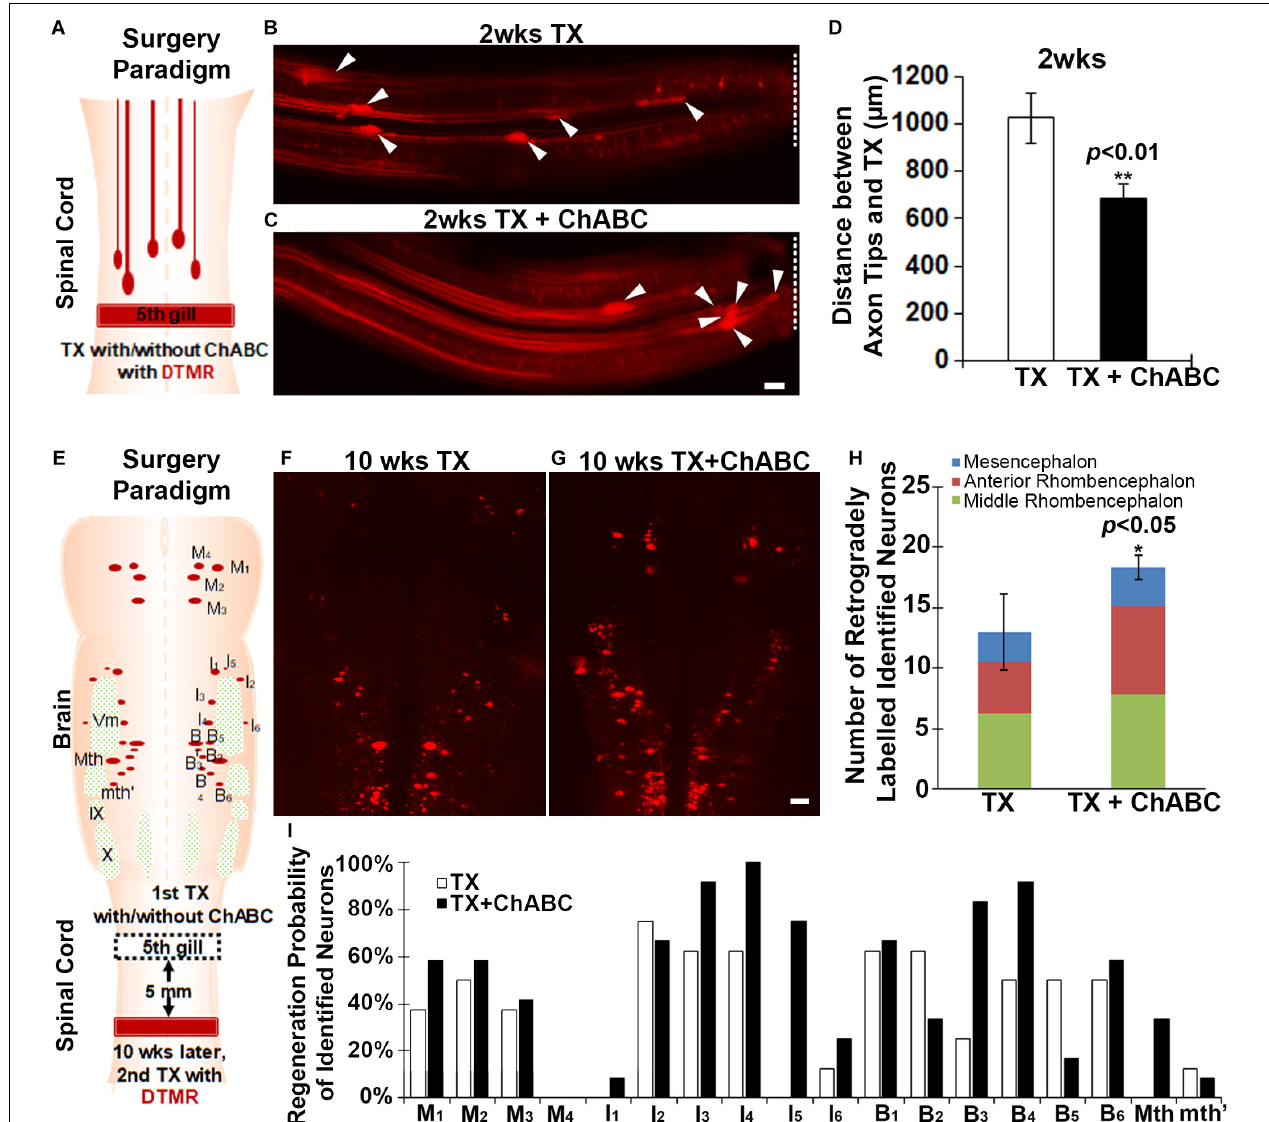
FIGURE 2 | ChABC slows initial axon retraction in vivo at 2 weeks and promotes axon regeneration in vivo at 10 weeks post-TX. (A) Experimental design for detecting the axon tips at 2 weeks post-TX. A solution of DTMR and either ChABC or control enzyme buffer was applied to a fresh spinal cord TX. (B,C) Axon tips (arrowheads) in the lamprey spinal cord back-filled with DTMR at 2 weeks post-TX (TX sites are labeled by dashed lines). (D) Mean distances of axon tips from the center of the TX site (dashed line). ** p < 0.01, n = number of axon tips. (E) Experimental design for detecting the neurons whose axons have regenerated by 10 weeks post-TX. The TX site was treated with either control enzyme buffer (F) , or ChABC (G) at the time of injury. Ten weeks later, DTMR was applied to a second TX 5 mm caudal to the first, and 1 week allowed for retrograde transport of the dye. (H) A graph showing an increased number of retrogradely labeled neurons in brains of animals treated with ChABC compared to controls. (I) The probability for each identified neuron that its axon will have regenerated at 10 weeks post-TX. * p < 0.05, n = 5 lampreys per group. Error bars: SEM. Scale bar: 100 µ m.